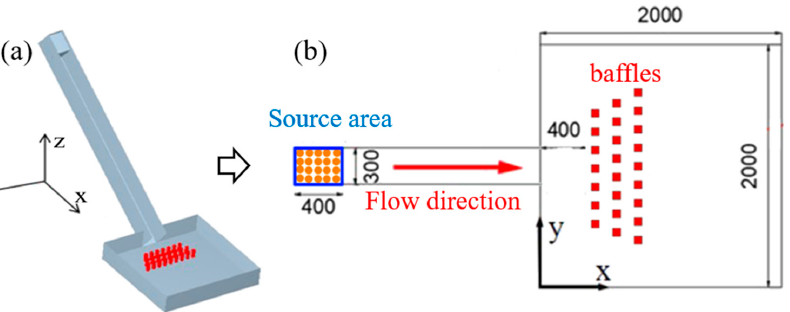
Figure 11. DEM model of debris flow impact baffle group: ( a ) 3D numerical model; ( b ) top view of the model.